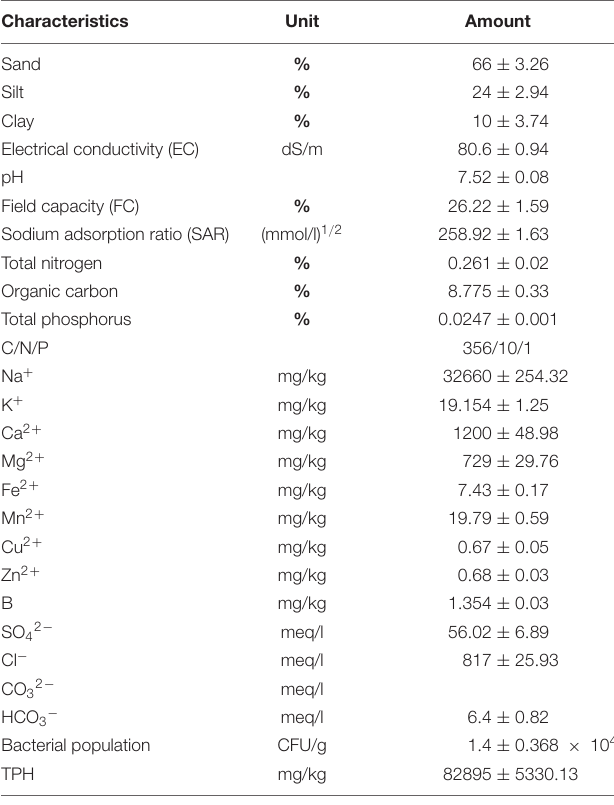
TABLE 1 | Physicochemical and biological petroleum-contaminated soil characteristics.